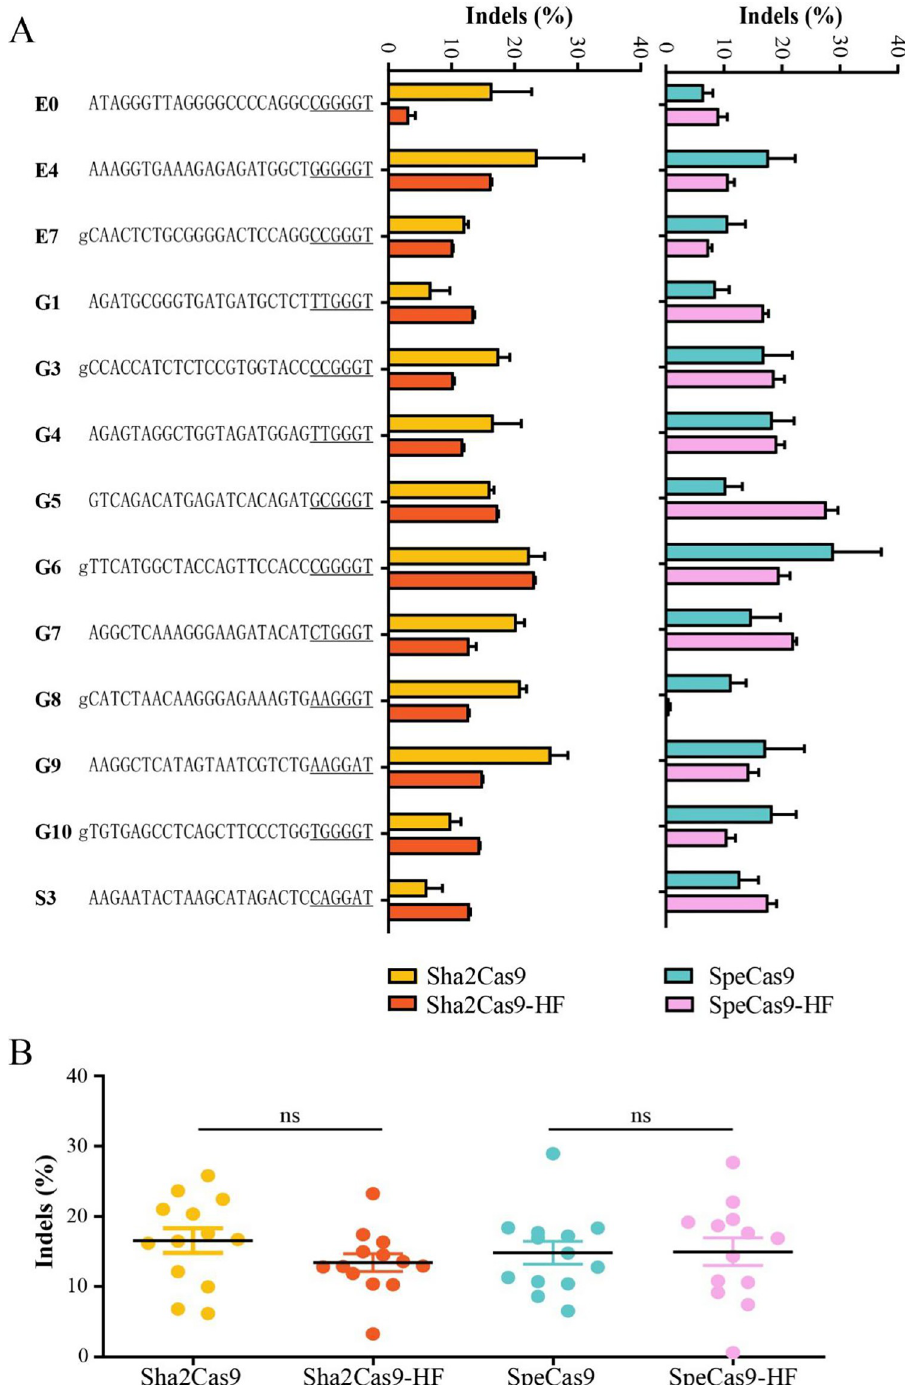
Fig 5. Evaluation of Sha2Cas9-HF and SpeCas9-HF on-target activities. ( A ) Comparison of activities of high-fidelity Cas9s to the wild-type Cas9s ( n = 3). The target sequences are shown on the left. PAM is underlined. If the first nucleotide is C or T, additional “g” is added for U6 promoter transcription. Underlying data for all summary statistics can be found in S1 Data. ( B ) Quantification of editing efficiency for SaCas9, SmiCas9, Sha2Cas9, and SpeCas9. Underlying data for all summary statistics can be found in S1